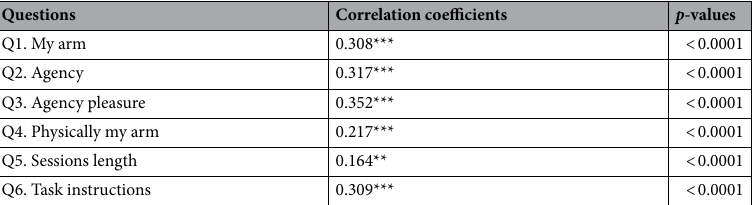
Table. 2. Relationship between the functional ability recovery of the arm after the cast removal (T1) with virtual reality questionnaire scores in immersive VR training group. There was a strong positive correlation between being embodied in a virtual body and the sense of controlling the virtual arm movements with the functional recovery of the fractured arm after the cast removal in immersive VR training patients.